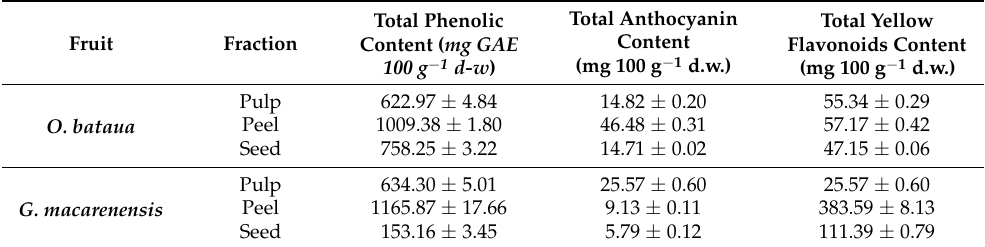
Table 4. Total phenolics content, and anthocyanin and yellow flavonoids content in the two Ecuado- rian fruits.